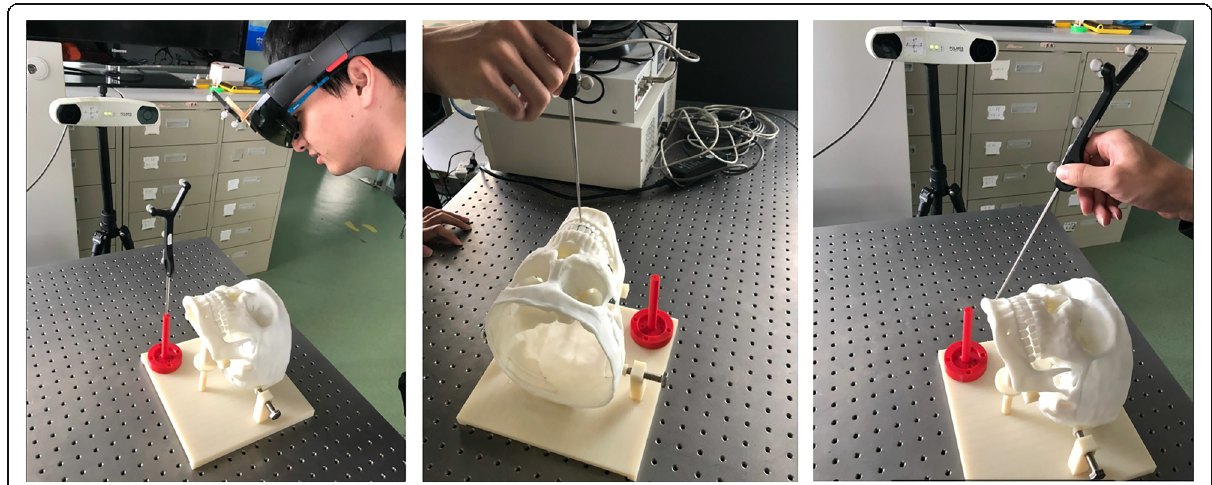
Fig. 6 Accuracy validation of the augmented reality-based neurosurgery navigation